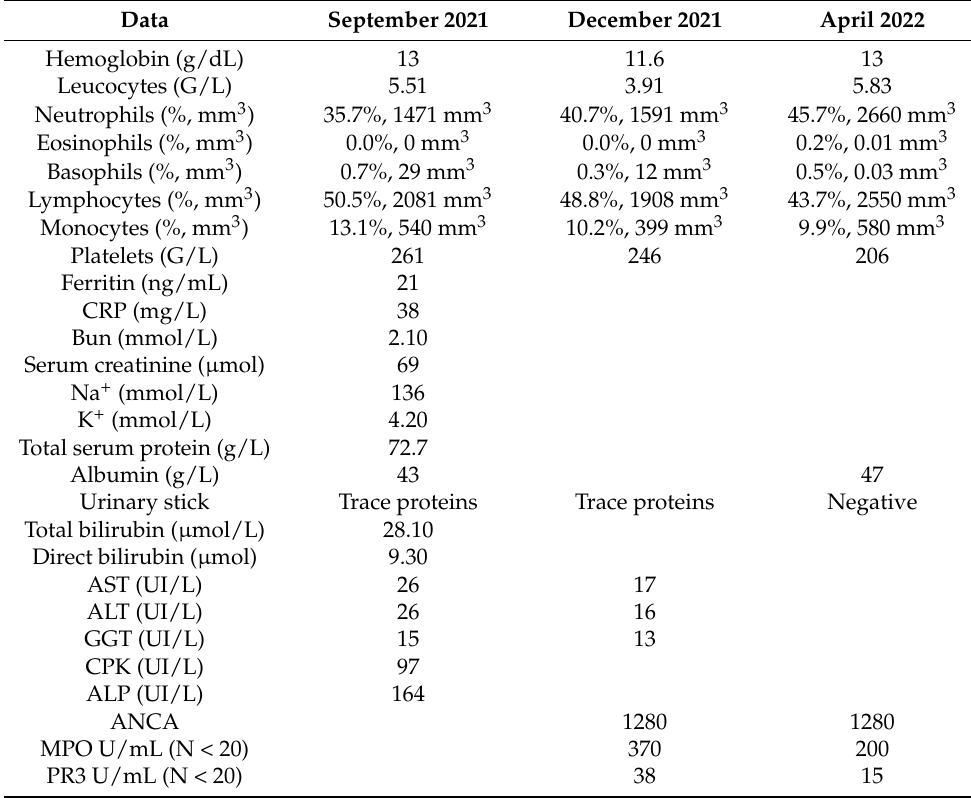
Table 1. Laboratory